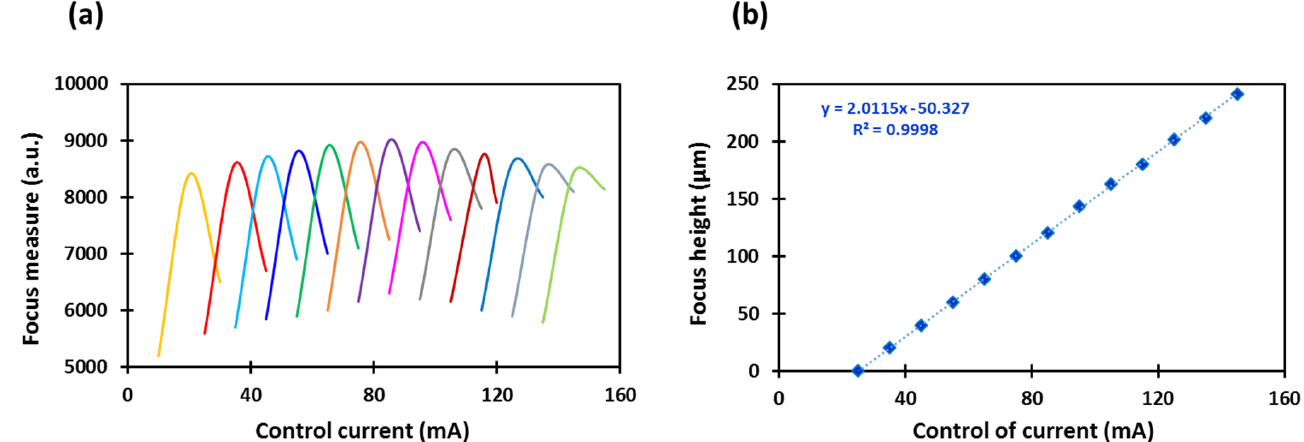
Figure 3. ( a ) Focus measure sweep as a function of tunable lens control current for different focus height and ( b ) focus height as a function of the tunable lens control current, calibration curve of the ETL imaging system.